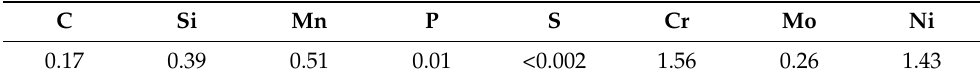
Table 1. Measured chemical composition of the AISI 4820 in wt. %.